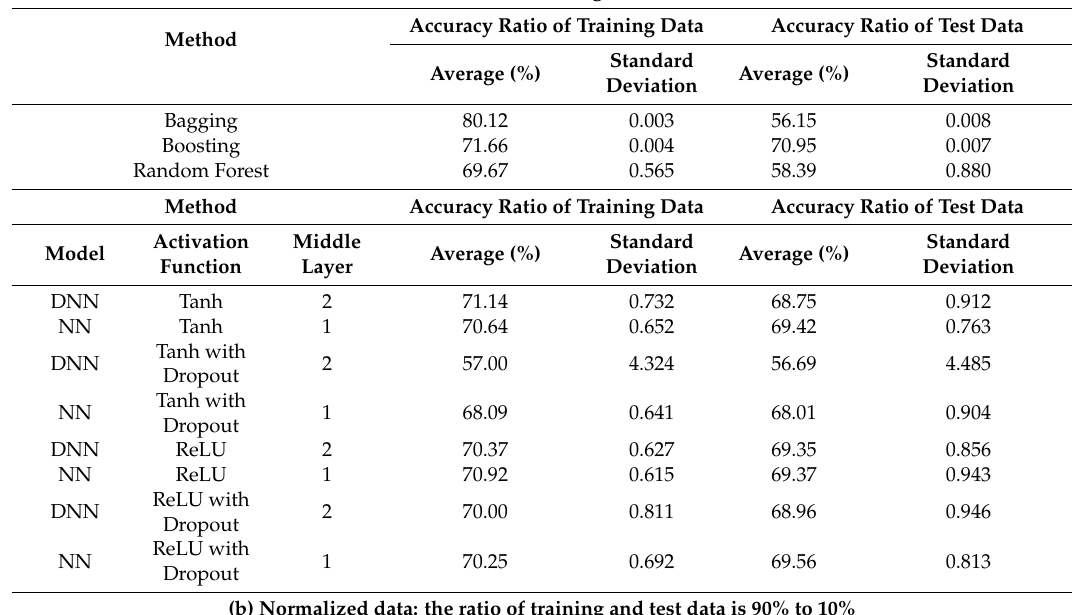
Table 3. Prediction accuracy of each method for normalized